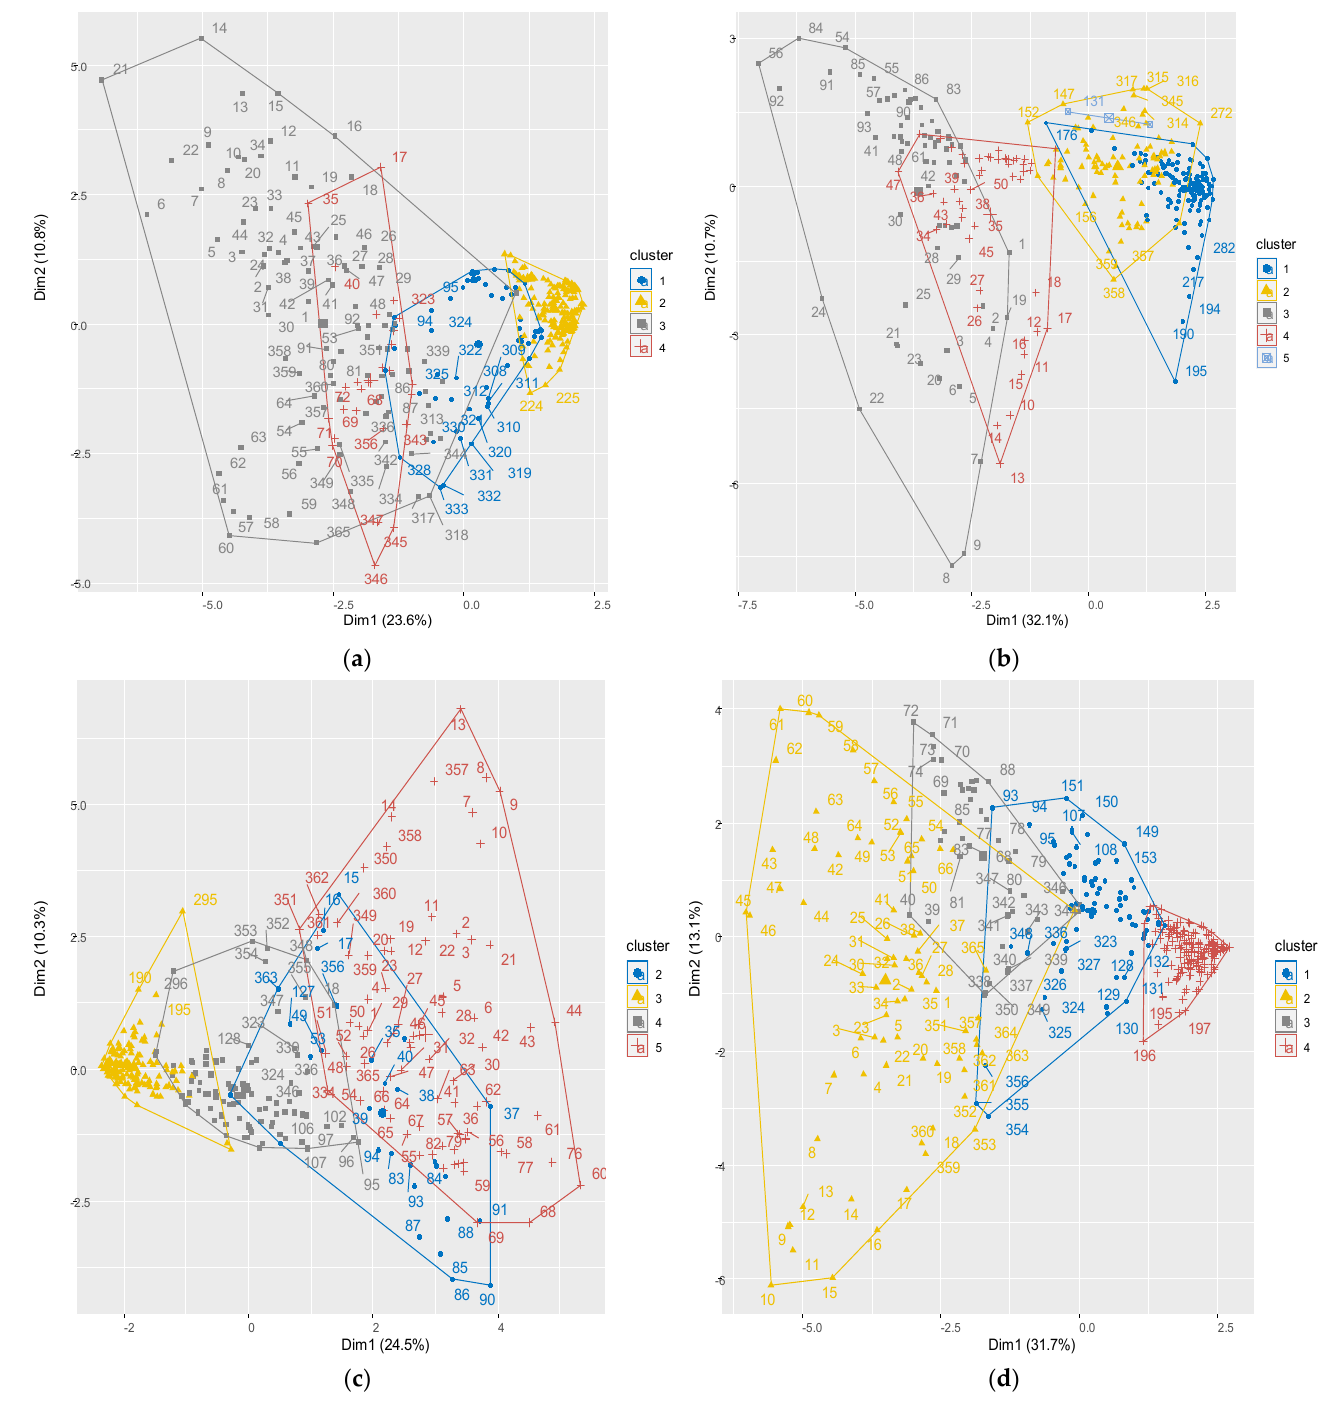
Figure 4. ( a ) Cluster plot for Biedenkopf; ( b ) cluster plot for Ehringen; ( c ) cluster plot for Günthers; ( d ) cluster plot for Hanau.